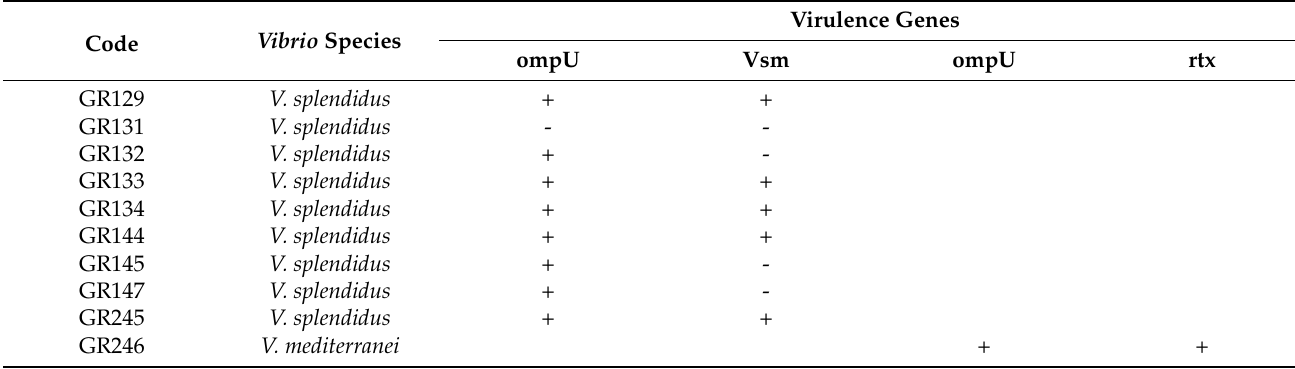
Table 2. Presence of virulence factors in V. splendidus and V. mediterranei identified bacteria. Positive samples are indicated with “+” and negative samples are indicated with “-“.